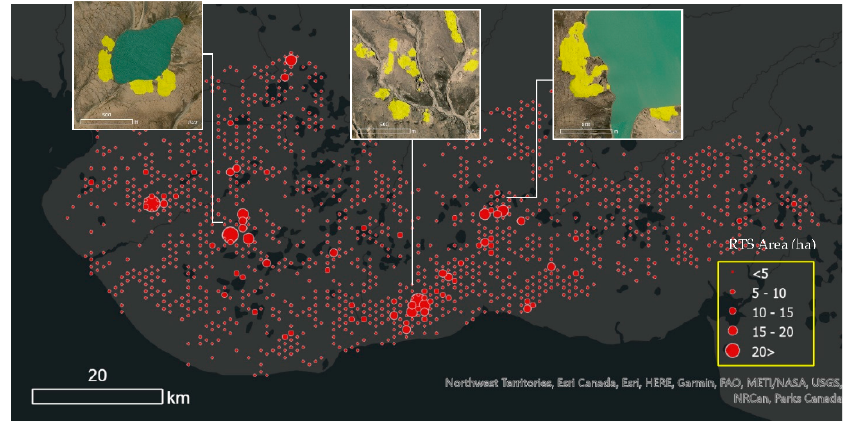
Figure 24. Retrogressive thaw slump (RTS) map for Banks Island based on the predictions of the optimal DLCNN model that was trained based on combined hand-annotated samples and optimal image tile size and network input size. The size of the map symbol (red circle) is proportional to the area (in ha) of the RTS falling inside a hexagonal grid. Each grid cell covers 100 ha. Yellow shading on zoomed-in views indicates detected RTS.